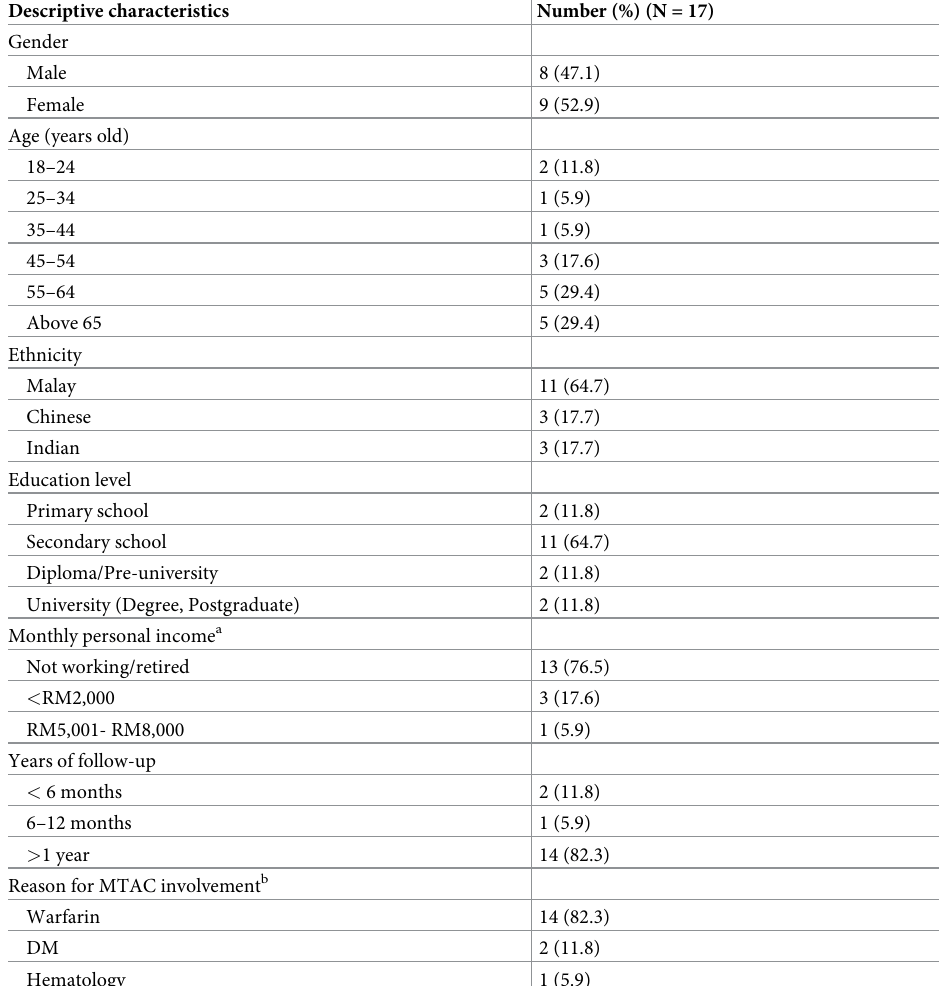
Table 3. Demographic characteristics of patients. Descriptive